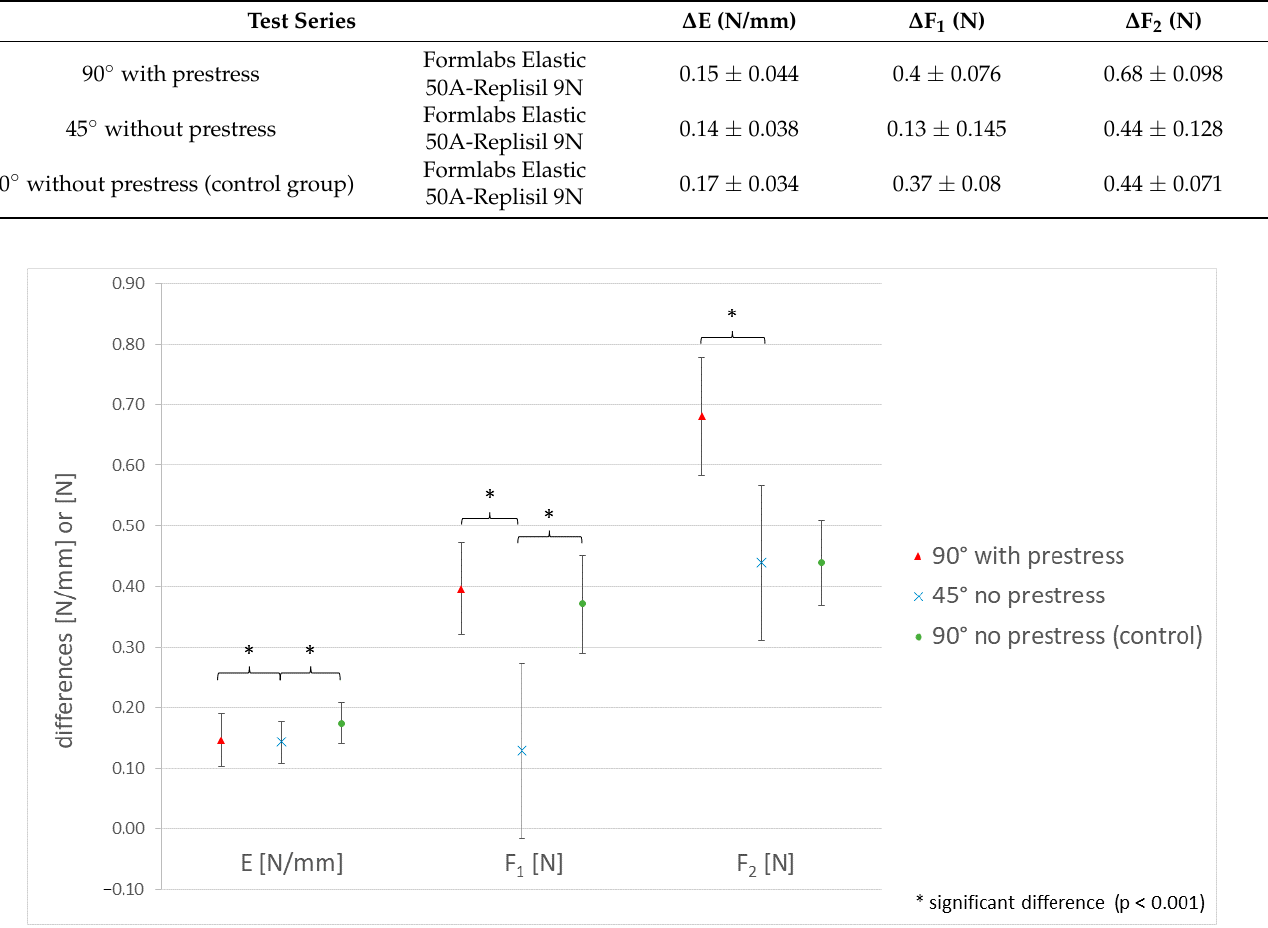
Figure 9. Visualization of the calculated means and standard deviations of the differences of all three parameters and groups. The gradient of the linear part ∆ E is in N/mm. The gradient of the first force maximum ∆ F 1 and the gradient of the following maximum force ∆ F 2 are in N. Table 3. Mean test results of the differences of the three parameters ∆ E, ∆ F 1 and ∆ F 2 with standard deviations. The gradient of the linear graph part ∆ E is in N/mm. The first force maximum ∆ F 1 and the following maximum force ∆ F 2 are in N.